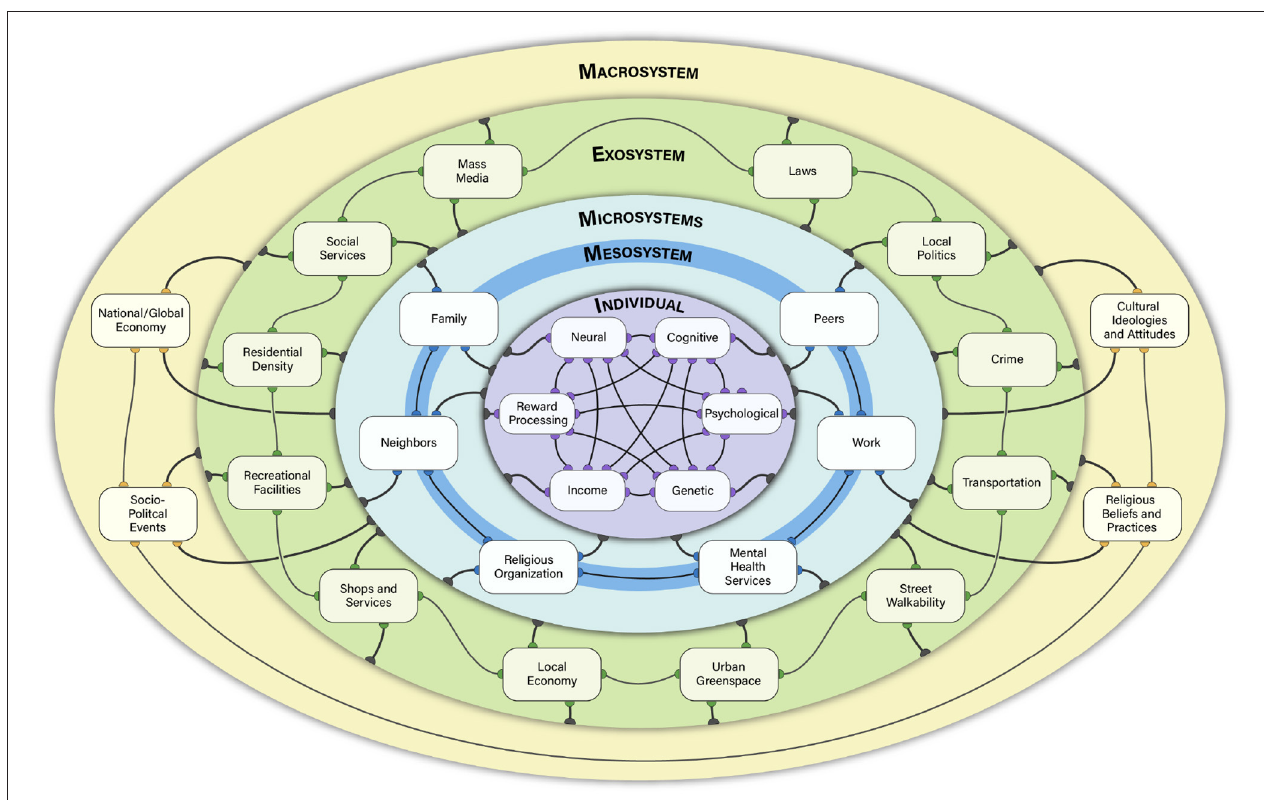
FIGURE 1 | Bioecosystem model of negative symptoms conceptual overview. In the bioecosystem theory, negative symptoms are influenced by dynamic interactions between person-level factors and environmental systems. The environmental systems differ in their proximity to the individual. The Microsystem represents the immediate environment. Multiple microsystems can exist (e.g., home, work, school). The mesosystem refers to connections or interactions between various microsystems (e.g., a friend from work also goes to the same church as the individual). The exosystem represents the indirect environment, which has the potential to act on the person. The Macrosystem reflects sociocultural factors. These systems are proposed to function as a dynamic and interactive network, with different levels of the ecosystem having differing influences on negative symptoms throughout phases of illness and development. Yellow, Macrosystem; Green, Exosystem; Light Blue, Microsystem; Dark Blue, Mesosystem; Purple, Person-Level Factors. Connections among the elements within the ecosystem are meant to be illustrative of potential network level interactions, rather than an exhaustive list of